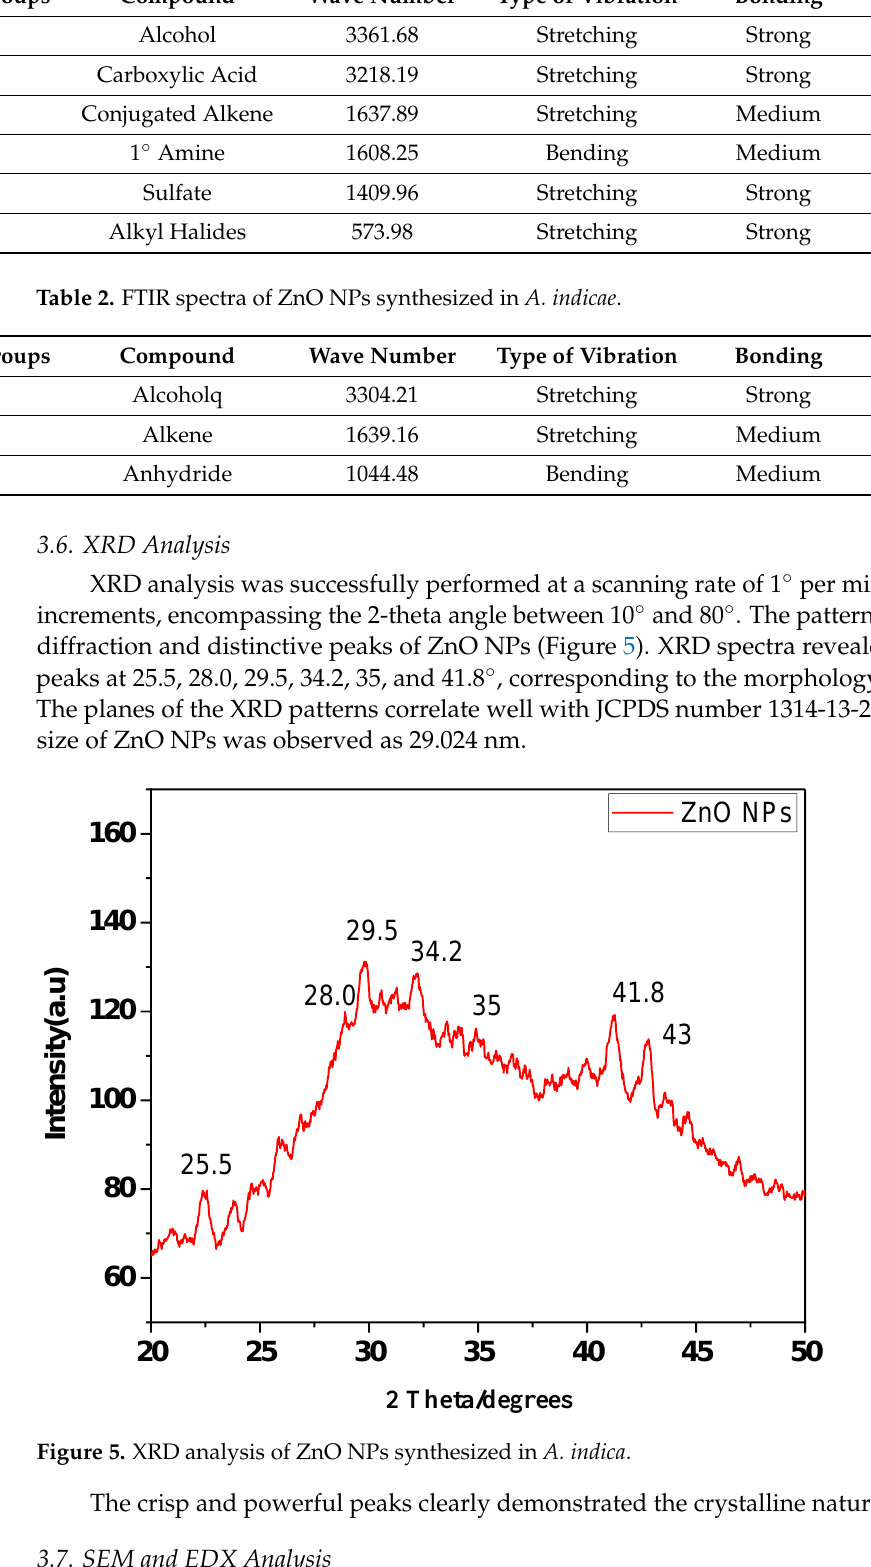
Table 1. FTIR spectra of ZnO NPs synthesized in A. indicae .